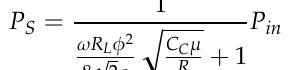
Figure 11. Circuit model for ESR-effect analysis.